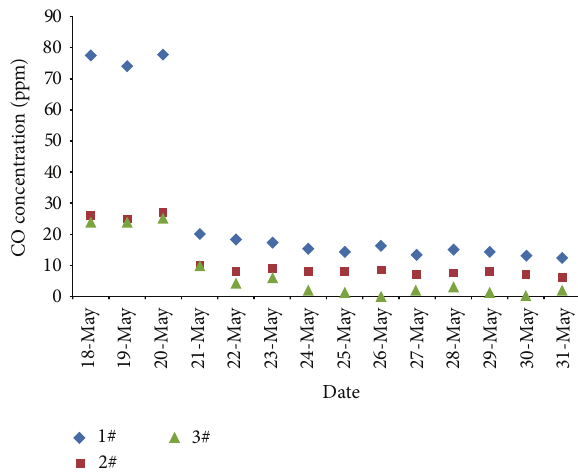
Figure 6: Temperature curve of monitoring sites after liquid nitrogen injection.